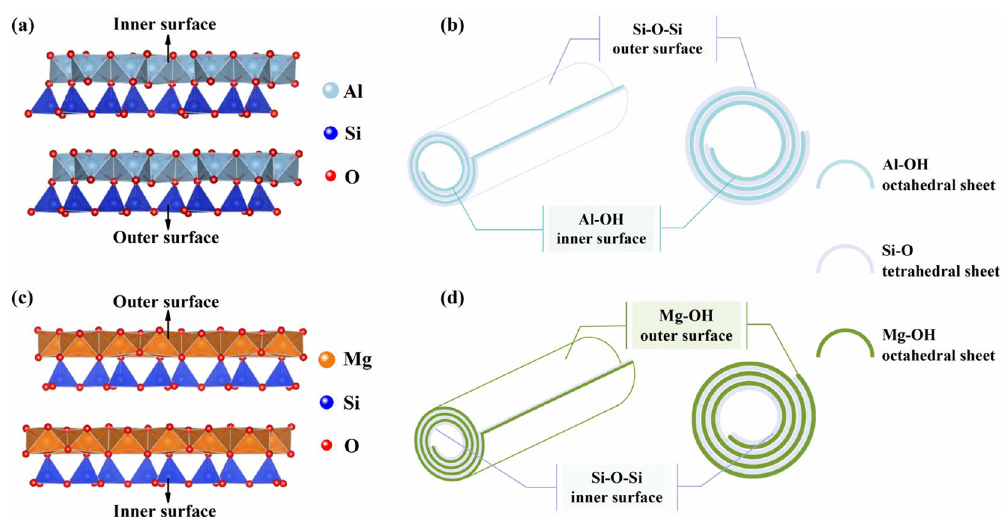
Figure 2. The crystal structure of kaolinite ( a ) and ChNT ( c ); the morphological diagrams of HNTs ( b ) and ChNTs ( d